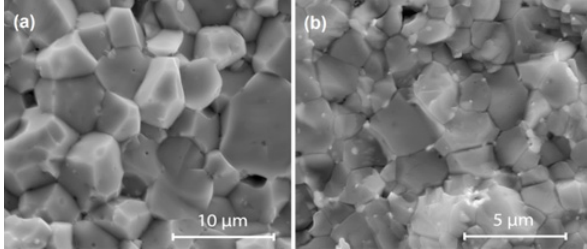
Fig. 7 SEM images of ceramic layers in ULTCC multilayer test structures sintered at 610 ℃ : (a) Li 2 WO 4 doped with 4% AlF 3 –CaB 4 O 7 and (b) Li 2 WO 4 doped with 4% CuBi 2 O 4 .